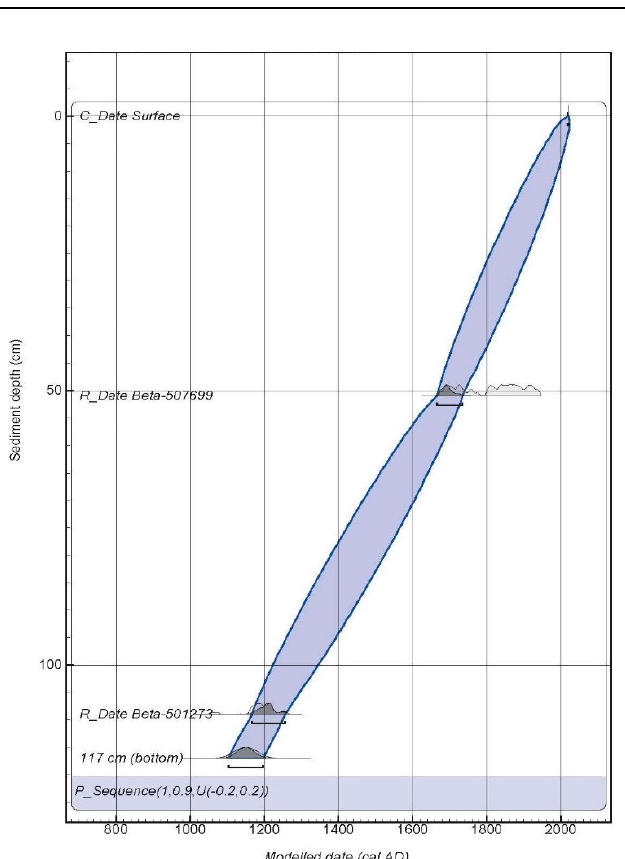
Figure 6. Bayesian age-depth model of composite profile SPUR-A from Spur Bog (excluding the Eocene clays at 117–129 cm depth). The model used the IntCal20 calibration curve [41] and the Ox- Cal v4.4.4 software [42].